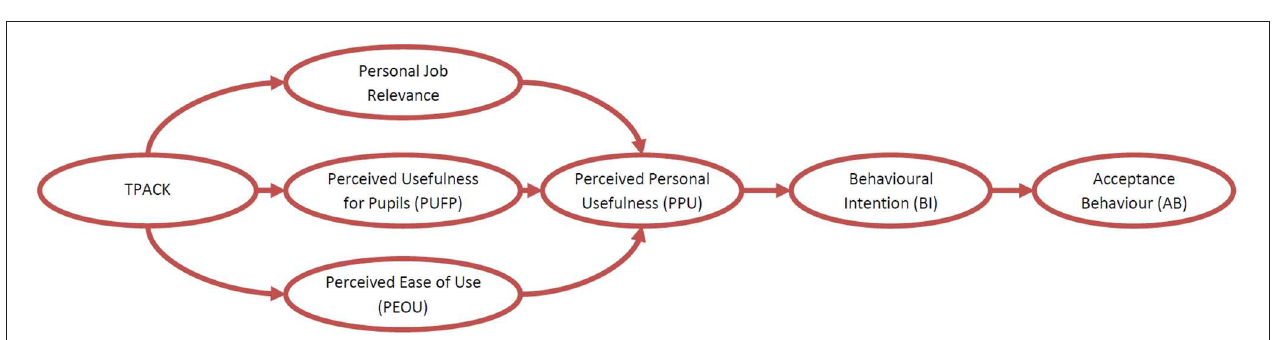
FIGURE 6 | Conceptual model of the adapted and extended UTAUT